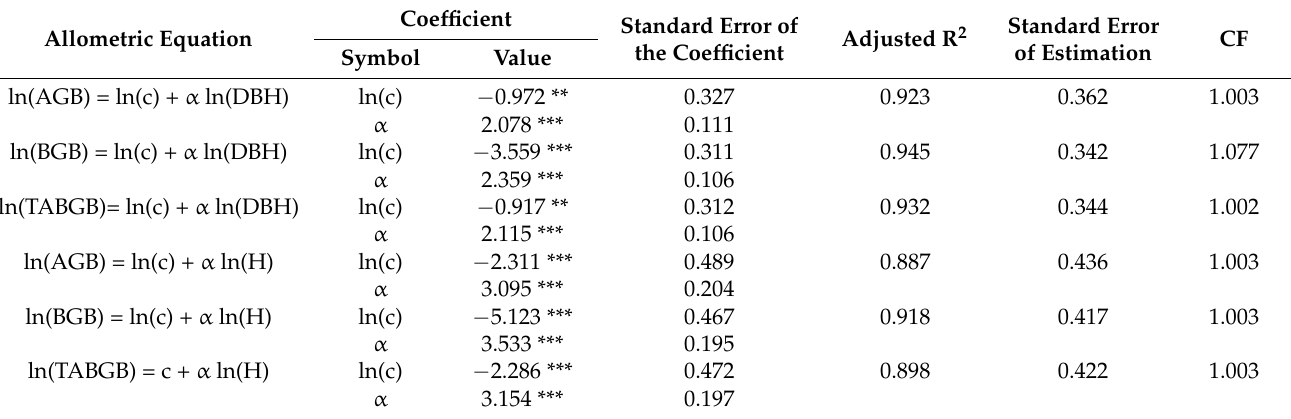
Table 4. Allometric equations for aboveground biomass, belowground biomass, and total above- and belowground biomass (using 30 tree samples).